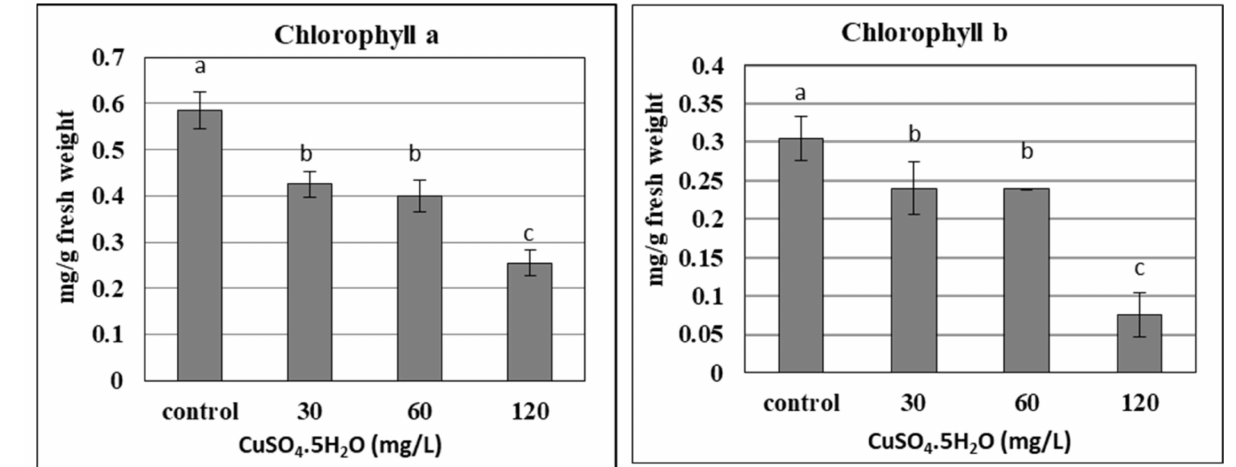
Figure 4. Effect of copper sulphate at 0.025, 30, 60, and 120 mg L − 1 on chlorophyll content of in vitro banana plantlets. Data represent the mean with SE. Letters above each bar shown the significant differences among the tested treatment, if letters were same corresponding treatments are statistically equal and vice versa according to Duncan’s multiple range tests at p < 0.05. Control = 0.025 mg L − 1 and represents the concentration of CuSO 4 5H 2 O in MS medium (without copper sulphate